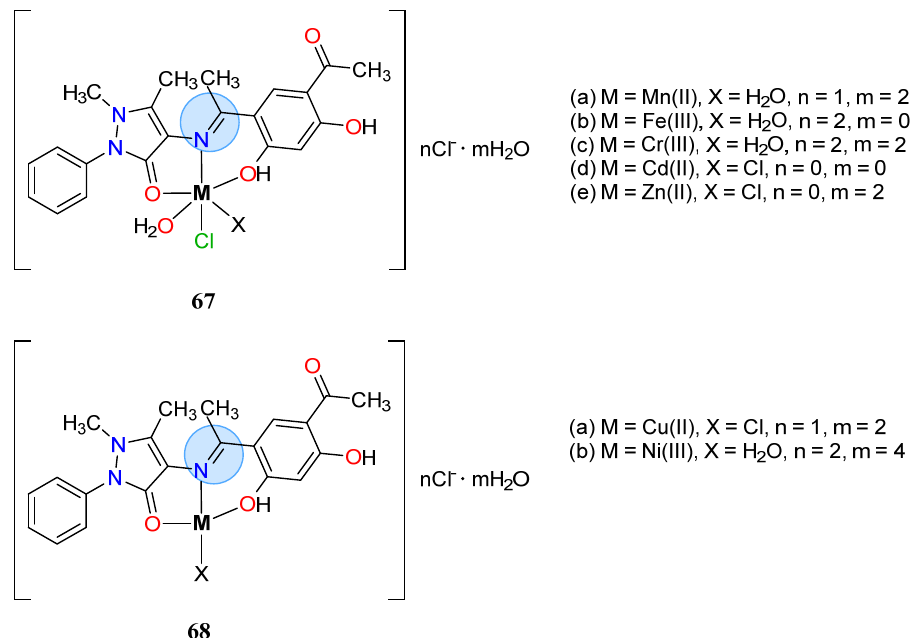
Figure 31. Mononuclear chelates of Mn(II), Fe(III), Cr(III), Cd(II), Zn(II), Cu(II), and Ni(II) from a new tridentate Schiff base ligand with antimicrobial properties.